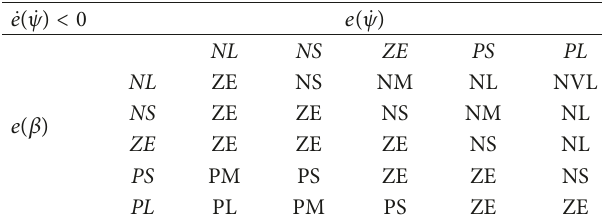
Table 2: Rules for negative yaw rate error derivative.